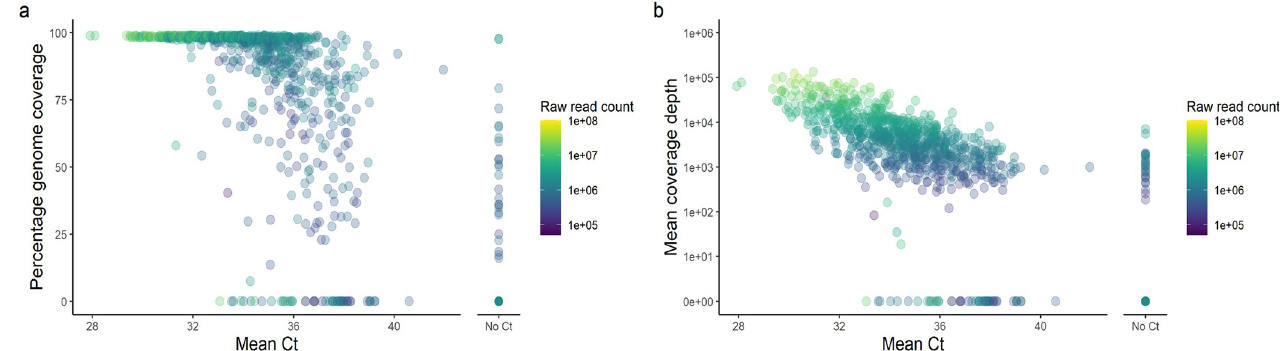
Fig 9. Results from high-throughput wastewater SARS-CoV-2 sequencing. Scatterplots of percentage coverage breadth (a) and mean coverage depth (b) against Ct values from SARS-CoV-2 RT-qPCR. Colour of points represents the number of raw sequencing reads obtained for each sample.